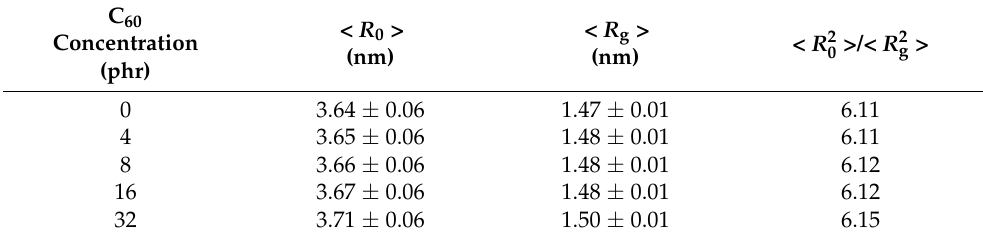
Table 2. Average end-to-end distance ( R 0 ), radius of gyration ( R g ) of cis -PI chains, and their polymer chain expansion factor (< R 2 >/< R 2 g >) as a function of C 60 concentration. 0